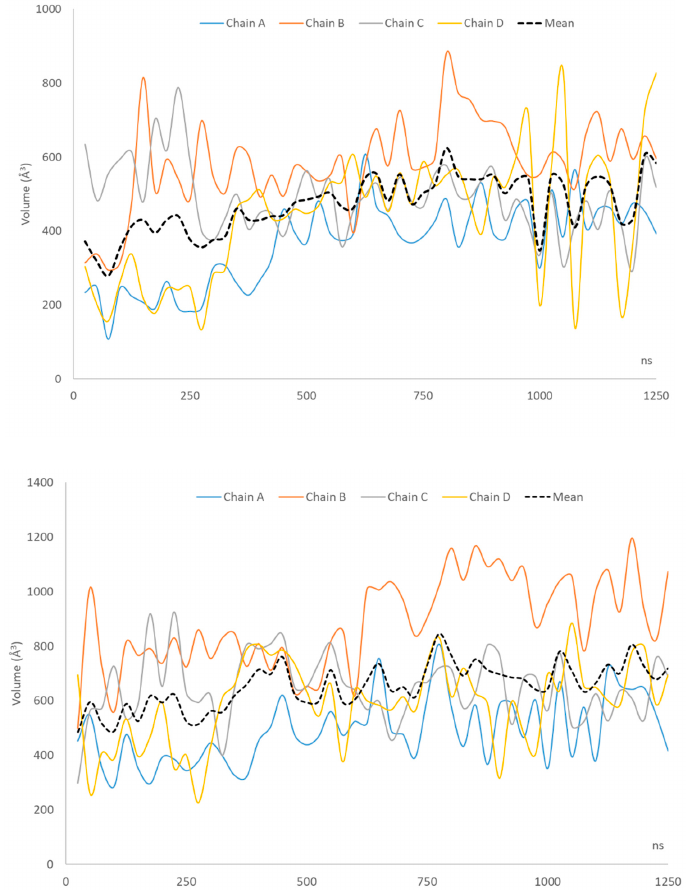
Figure 2. Profiles of the volumes of the four binding pockets within non-optimized ( top panel ) and optimized ( bottom panel ).